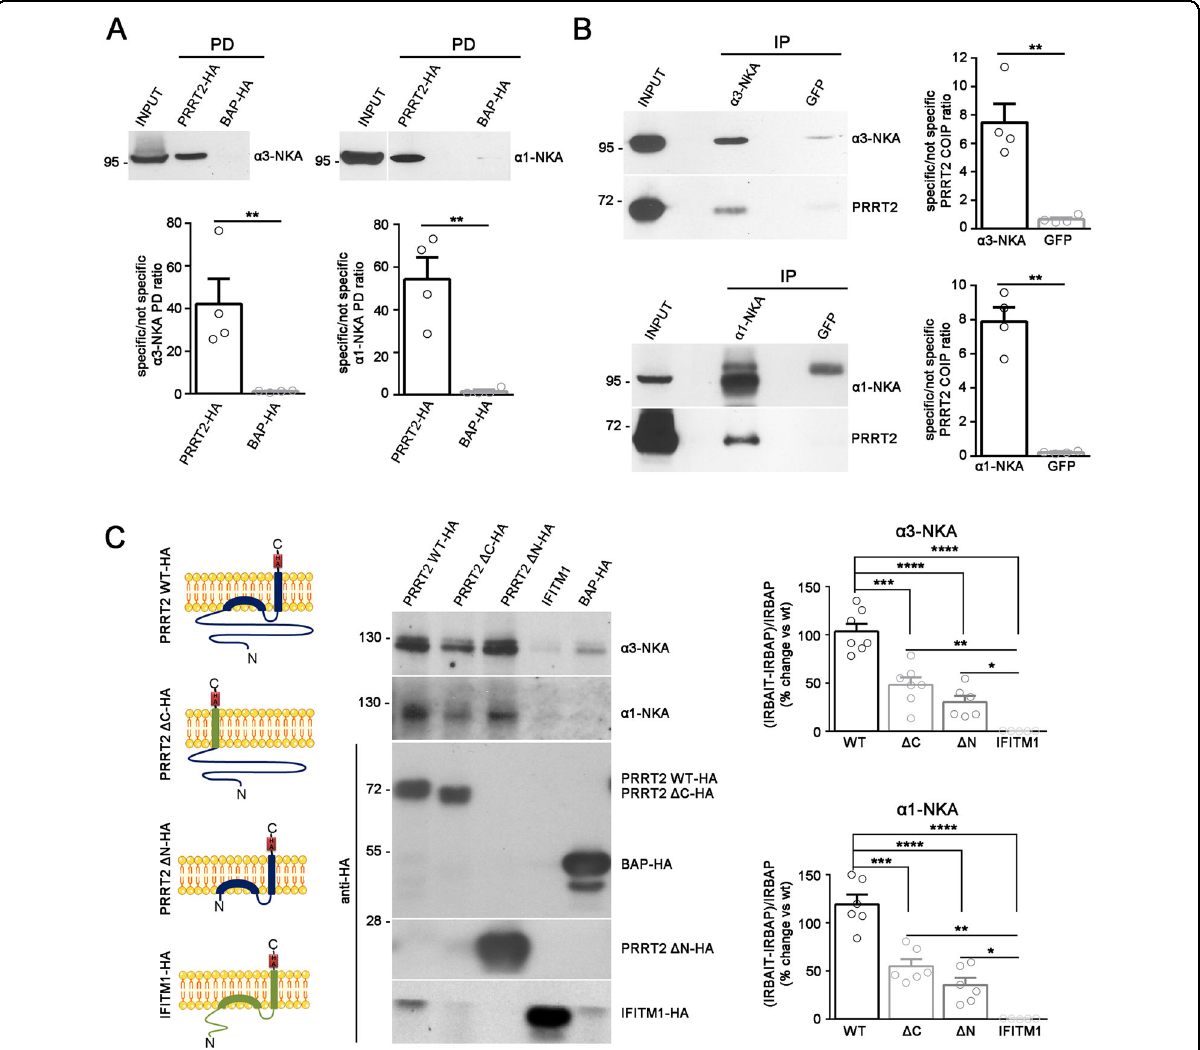
Fig. 1 PRRT2 interacts with α 3-NKA and α 1-NKA subunits. A Pulldown of α 3-NKA and α 1-NKA by PRRT2 : Af fi nity-puri fi ed PRRT2-HA or BAP-HA were incubated with total mouse brain extracts. After pulldown (PD), pellets were solubilized and subjected to western blotting with α 3-NKA and α 1-NKA antibodies. Mouse brain lysates incubated with PRRT2-HA showed speci fi c immunoreactivity for α 3-NKA and α 1-NKA in the precipitates, which were not detected with BAP-HA. Top: Representative immunoblots are shown. Bottom: Quanti fi cation of the α 3-NKA and α 1-NKA immunoreactivities in the pulled down samples normalized to the BAP-HA control (means ± SEM, n = 4 independent experiments, ** p < 0.01; unpaired Student ’ s t -test). Input, 10 μ g total extract. B Co-immunoprecipitation of PRRT2 with α 3-NKA and α 1-NKA antibodies : Detergent extracts of mouse brain were immunoprecipitated (IP) with monoclonal antibodies (mAbs) to α 3-NKA, α 1-NKA or GFP (used as a control), as indicated. After the electrophoretic separation of the immunocomplexes and western blotting, membranes were probed with α 3-NKA or α 1-NKA antibodies to test the immunoprecipitation ef fi ciency, as well as with polyclonal PRRT2 antibodies to test for co-immunoprecipitation. Left: Representative immunoblots are shown. Right: Quanti fi cation of the PRRT2 immunoreactive signal in the immunoprecipitated samples normalized to the GFP nonspeci fi c signal (means± SEM, n = 4 independent experiments, ** p < 0.01; unpaired Student ’ s t -test). Input, 10 μ g t otal extract. C Both the cytosolic and membrane- associated domains of PRRT2 are necessary for the interaction with NKA. Left: Schematics of the PRRT2 domain constructs. PRRT2 Δ C-HA is a chimeric protein composed of the cytoplasmic domain of PRRT2 (violet) anchored to the membrane by the transmembrane domain of IFITM1 (green). PRRT2 Δ N-HA is composed of the transmembrane domain of PRRT2. The IFITM1 protein (green) was used as a control. Middle: COS-7 cells were co- transfected with full length PRRT2 WT-HA, PRRT2 Δ C-HA, PRRT2 Δ N-HA, IFITM1-HA or BAP-HA constructs and either α 3-NKA-SEP or α 1-NKA-SEP constructs. Samples were immunoprecipitated by anti-HA beads (IP) and analyzed by western blotting with antibodies to α 3-NKA, α 1-NKA and HA. Representative immunoblots are shown. Horizontal white lines in the blot indicate that proteins of different molecular mass were separated on the same original gel and subjected to immunoblotting assays in distinct nitrocellulose strips. Right: Densitometric analysis of the fl uorograms obtained in the linear range of the emulsion response. The immunoreactivity (IR) of the bait-speci fi c pulldown with respect to the non-speci fi c BAP control [(IRBAIT – IRBAP)/IRBAP] was calculated, normalized by the amount of each BAIT, and expressed in percent of the PRRT2 WT-HA. Means ± SEM of n = 6 independent experiments; * p < 0.05, ** p < 0.01, *** p < 0.001, **** p < 0.0001; one-way ANOVA/Tukey ’ s